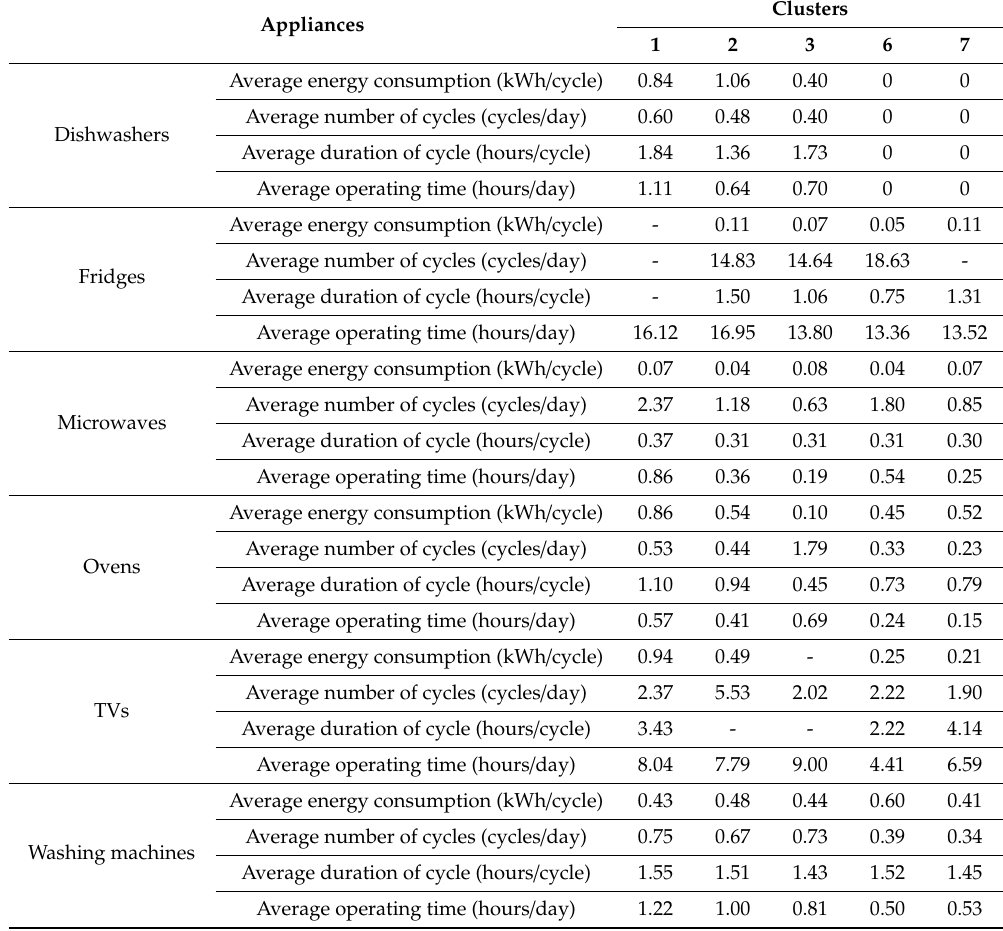
Table 8. Appliance usage characteristics by type and by